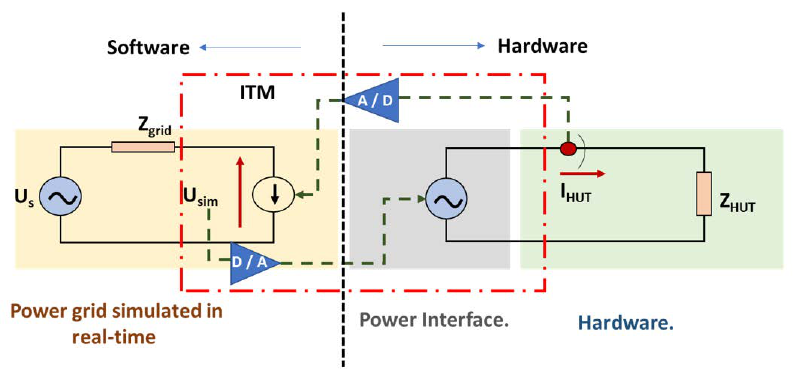
Figure 1. Power hardware-in-the-loop (PHIL) system architecture with ideal transformer model- voltage type